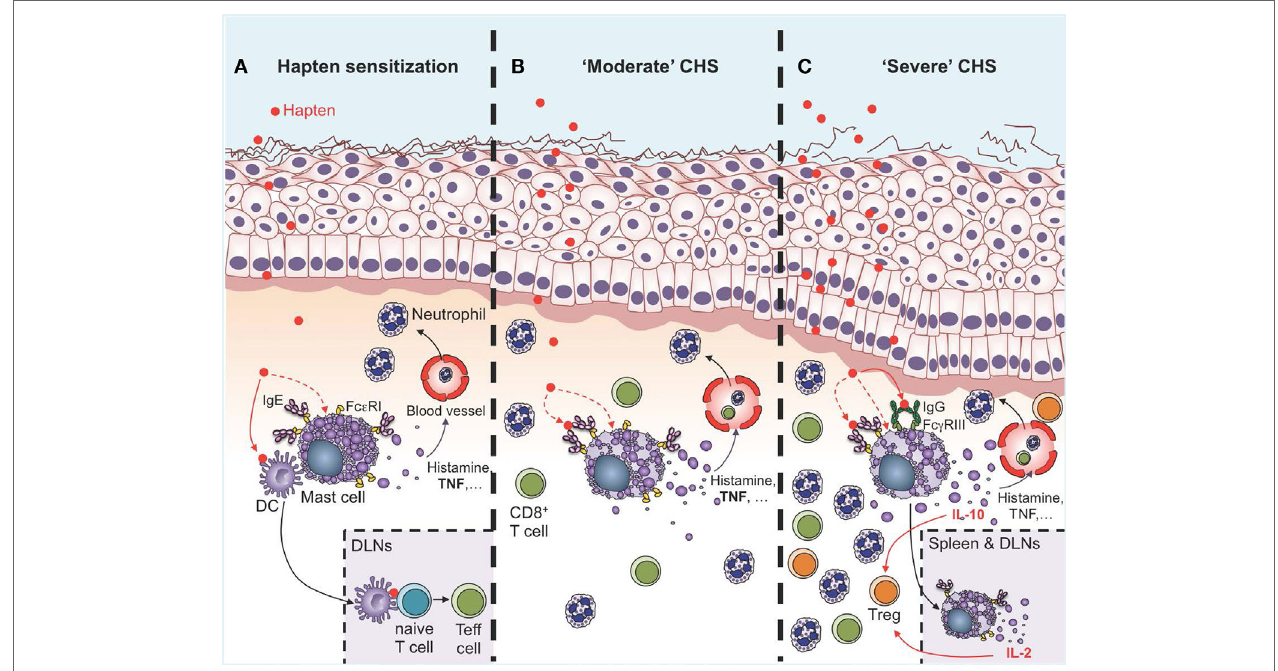
FiGURe 2 | Roles of mast cells (MCs) in the sensitization and effector phases of contact hypersensitivity (CHS). (A) During the sensitization phase, MCs are activated directly or indirectly by haptens to release of a diverse spectrum of mediators, including histamine and TNF, which induce vasodilatation and recruitment of leukocytes, mainly neutrophils. Multiple lines of evidence suggest that IgE can amplify MC activation in the sensitization phase though antigen-independent cytokinergic effects. Direct cell-to-cell contacts between MCs and dendritic cells (DCs), as well as MC-derived TNF, can amplify DC migration to the draining lymph nodes (DLNs), where these cells prime naïve T cells to become effector cells (Teff cells) via antigen presentation. (B) During “moderate” CHS responses, MCs and MC-derived TNF amplify ear swelling, leukocyte recruitment (mainly neutrophils and CD8 + T cells), and epidermal hyperplasia. Evidence suggests that IgE and Fc ε RI can amplify the pro-inflammatory functions of MCs in moderate CHS (C) . During more severe (and chronic) CHS responses, MCs represent an early source of IL-10 in the skin, which amplifies recruitment of regulatory T cells (Treg) and limits ear swelling and epidermal hyperplasia. MC activation in the skin is amplified by the engagement of Fc γ RIII by hapten-IgG immune complexes. Additionally, MCs can migrate to the DLNs and the spleen in an IgE-dependent manner, where they produce IL-2 which helps in maintaining the Teff:Treg ratio at the site of inflammation, and thereby contributes to limiting the severity of CHS